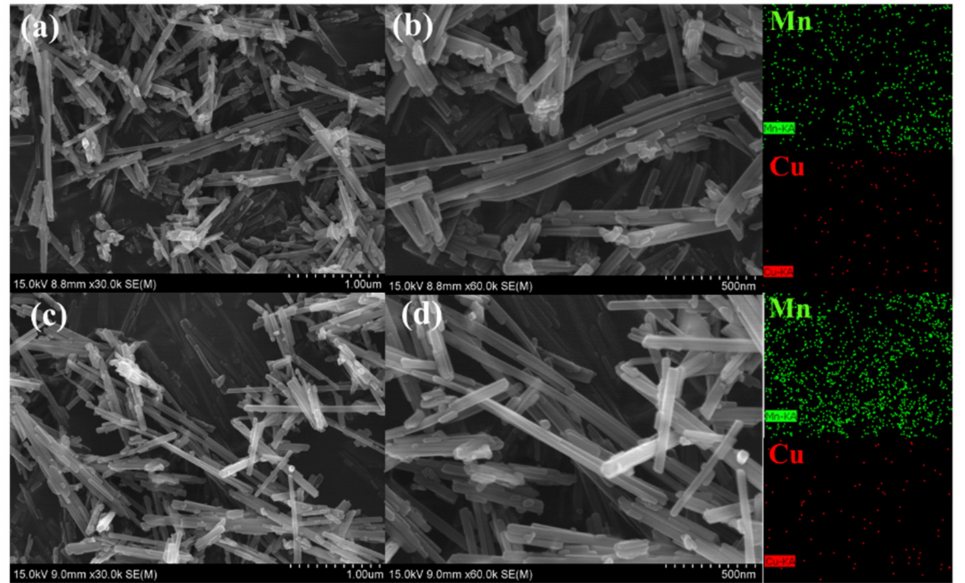
Figure 3. STEM and EDS element mapping images showing the spatial distribution of Mn and Cu elements: ( a , b ) 3CuO/ α -MnO 2 -200-DP, ( c , d ) 3CuO/ α -MnO 2